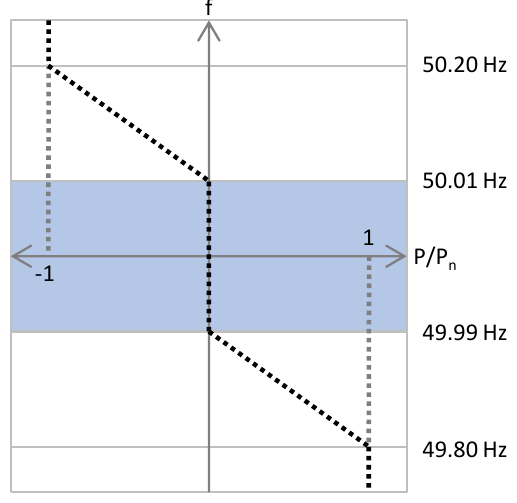
Figure 2. P - f characteristics for providing PCR.